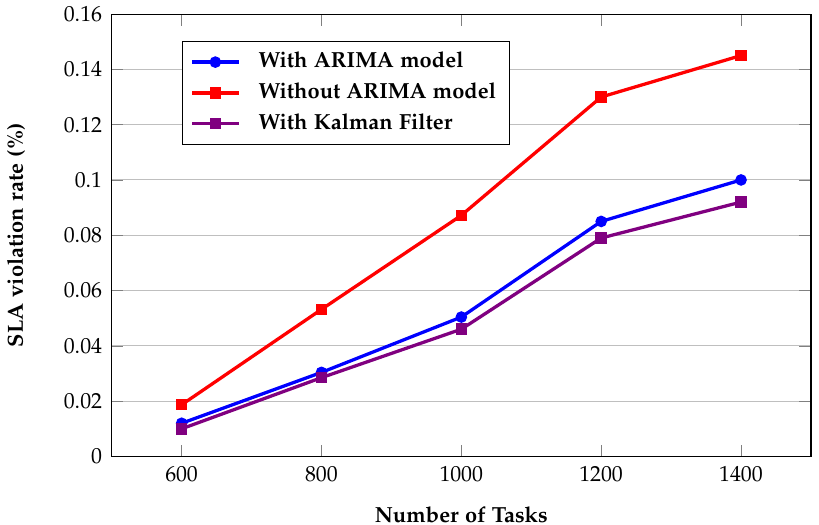
Figure 10. Effect of the prediction model on the proposed algorithm HPSO.